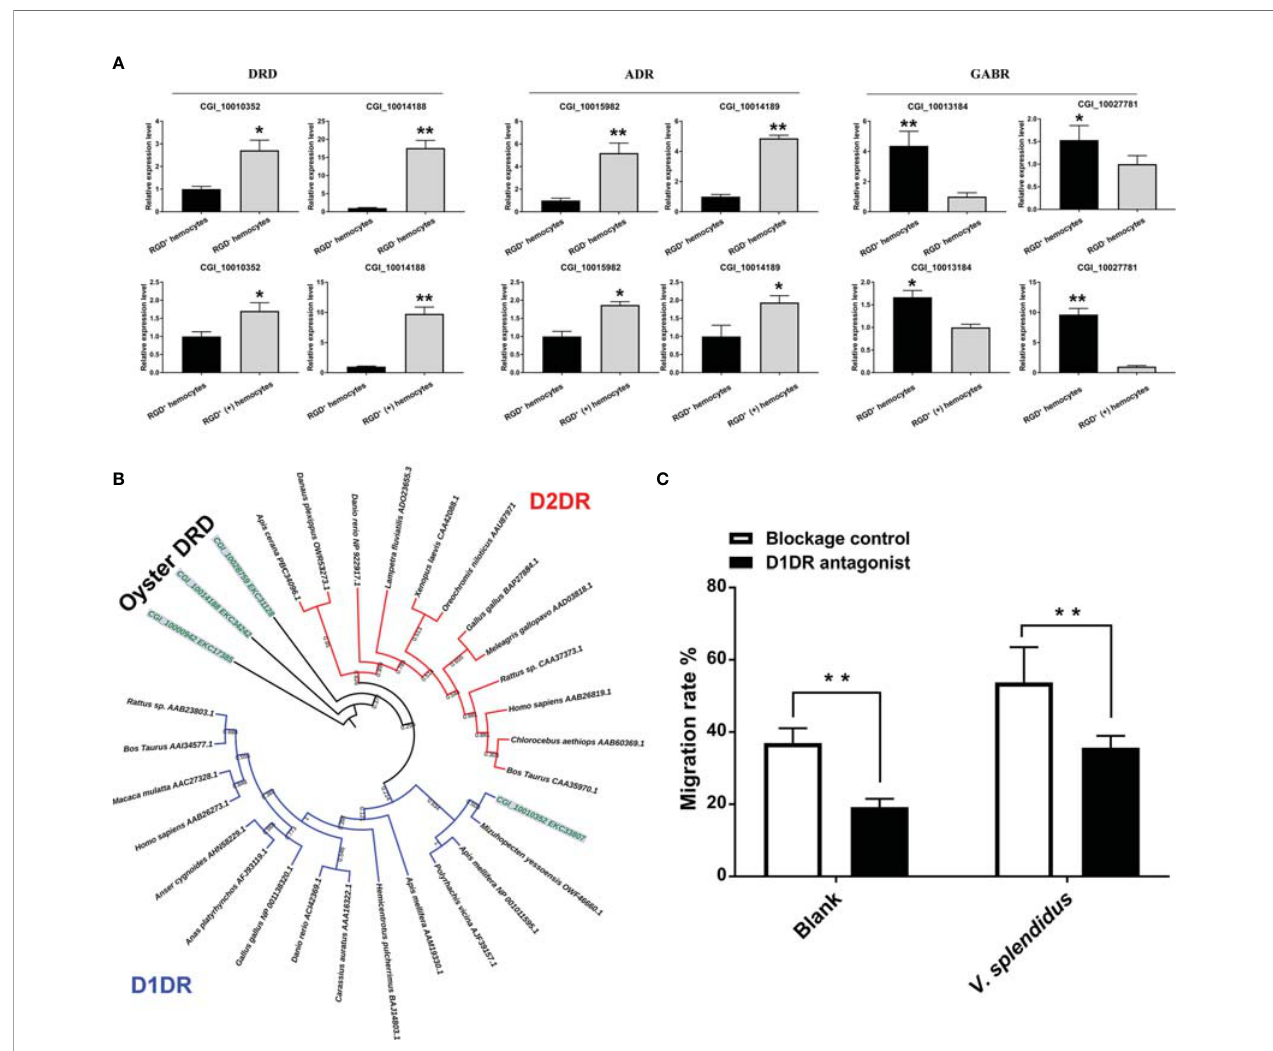
FIGURE 7 | The involvement of the neuroendocrine system in regulating migration activity in response to V. splendidus . (A) qPCR validation of differentially expressed neuroendocrine factor receptor genes in resting RGD + hemocytes compared to resting RGD - hemocytes and in activated RGD + (+) hemocytes compared to resting RGD + hemocytes. (B) The dendrogram tree of the four differentially expressed DRDs. (C) Changes in migration activity after RGD + hemocytes were blocked by a D1DR receptor inhibitor. The double asterisks (**) indicate statistical signi fi cance at p < 0.01, and the asterisk (*) indicates statistical signi fi cance at p <